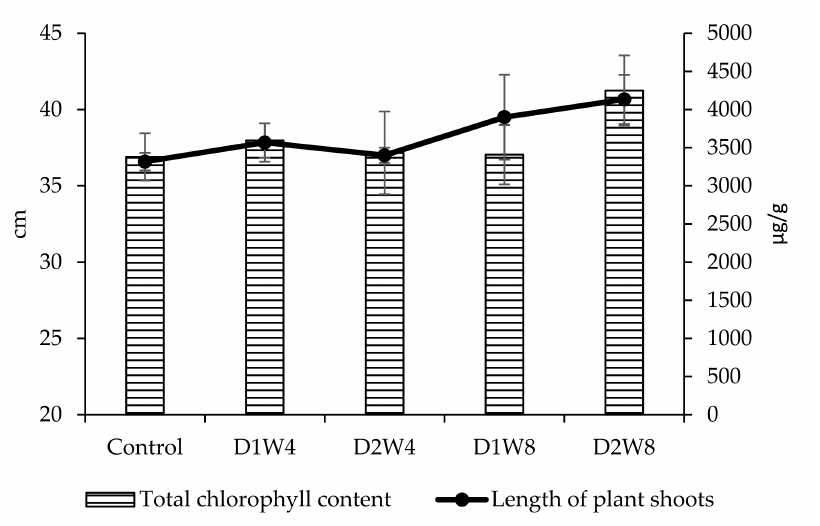
Figure 10. Changes in total chlorophyll content and plant shoot length of slightly humous Arenosol soil. The codes are as follows: D1W4: Dose 1 Week 4. D2W4: Dose 2 Week 4. D1W8: Dose 1 Week 8. D2W8: Dose 2 Week